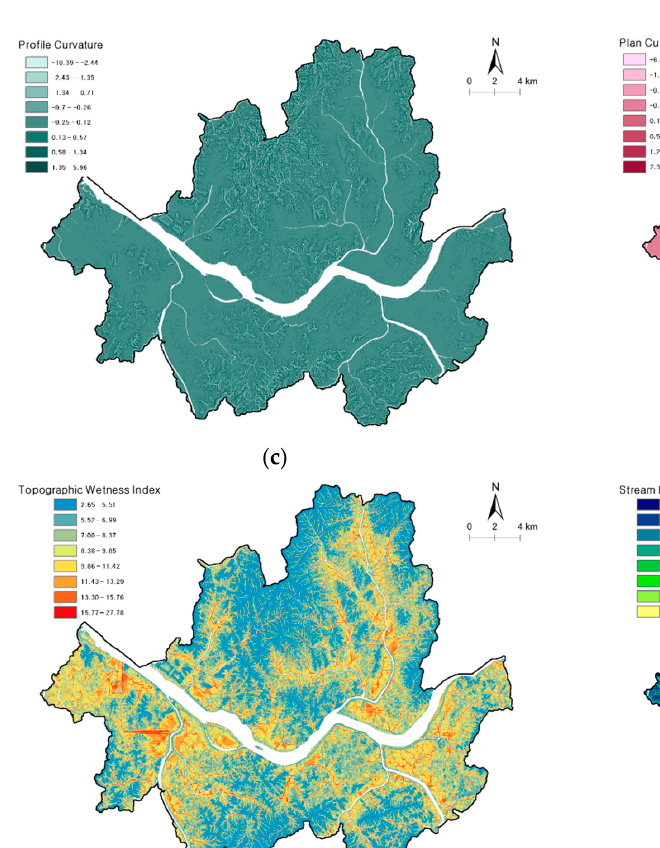
Figure 4. Illustrations by type of curvature: ( a ) Profile curvature; ( b ) Plan curvature [30].